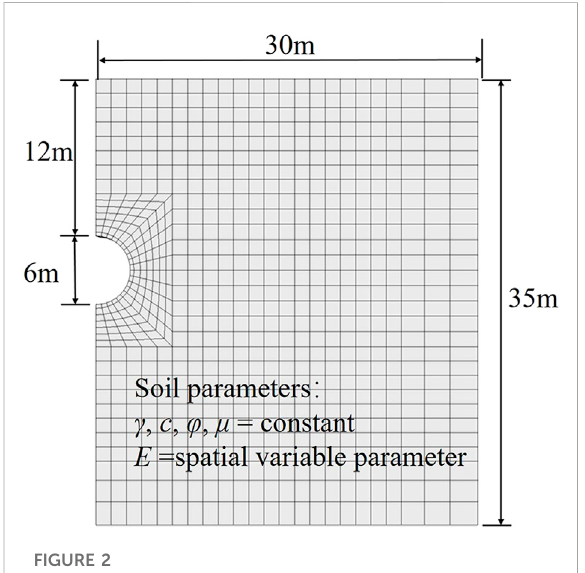
FIGURE 2 Typical mesh and model domain for example I.